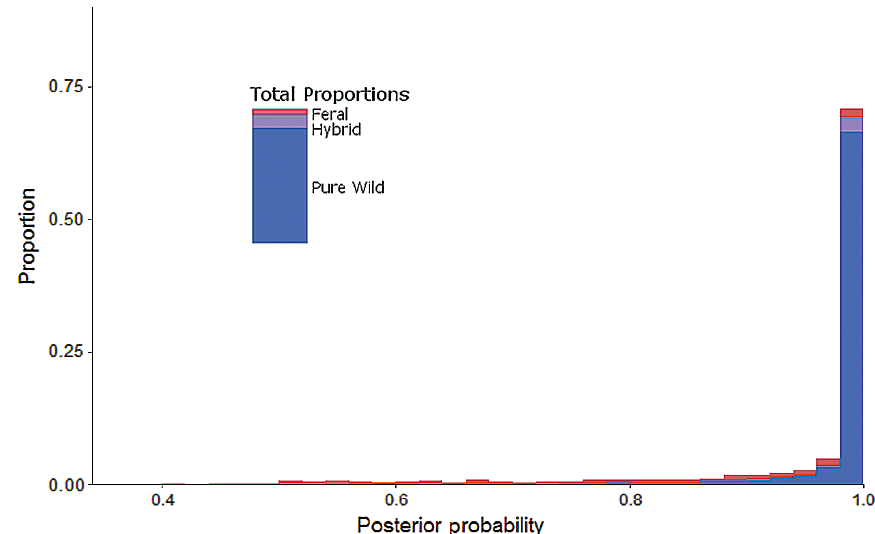
Fig. 2. Frequency distribution of posterior probability (PP) from N EWHYBRIDS classifica- tion. Colours indicate assigned group with all Atlantic salmon hybrid classes (F 1 , F 2 , backcross wild [BCW], and backcross farmed [BCF]) combined into a single group. Embedded panel shows overall class proportions of individuals over the PP threshold, 0.8